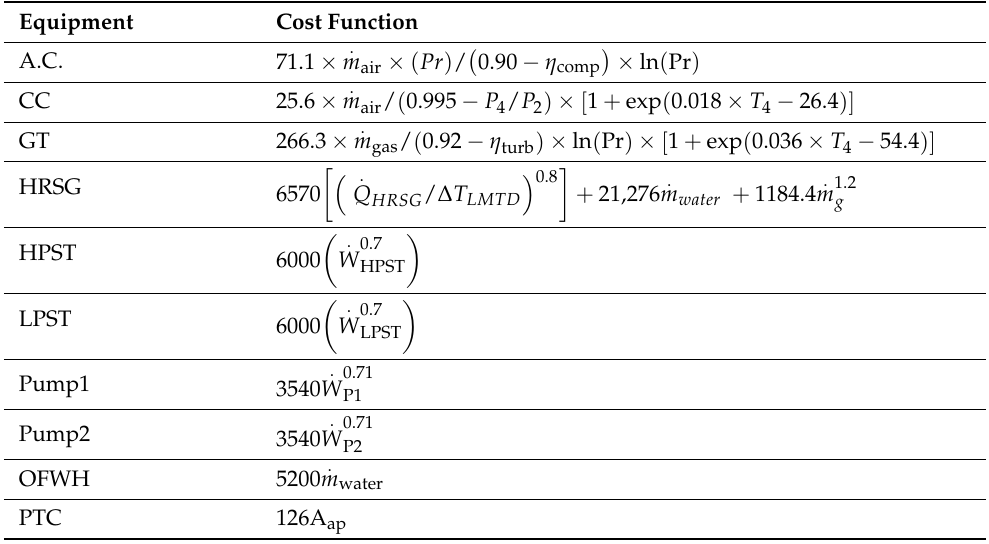
Table 4. Purchased equipment cost [40–42].